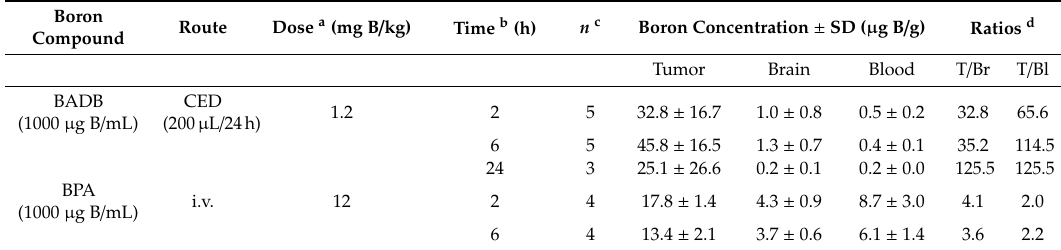
Table 1. Summary of biodistribution study with BPA and BADB in brain tumors and blood. i.v.: intravenous; CED: convection-enhanced